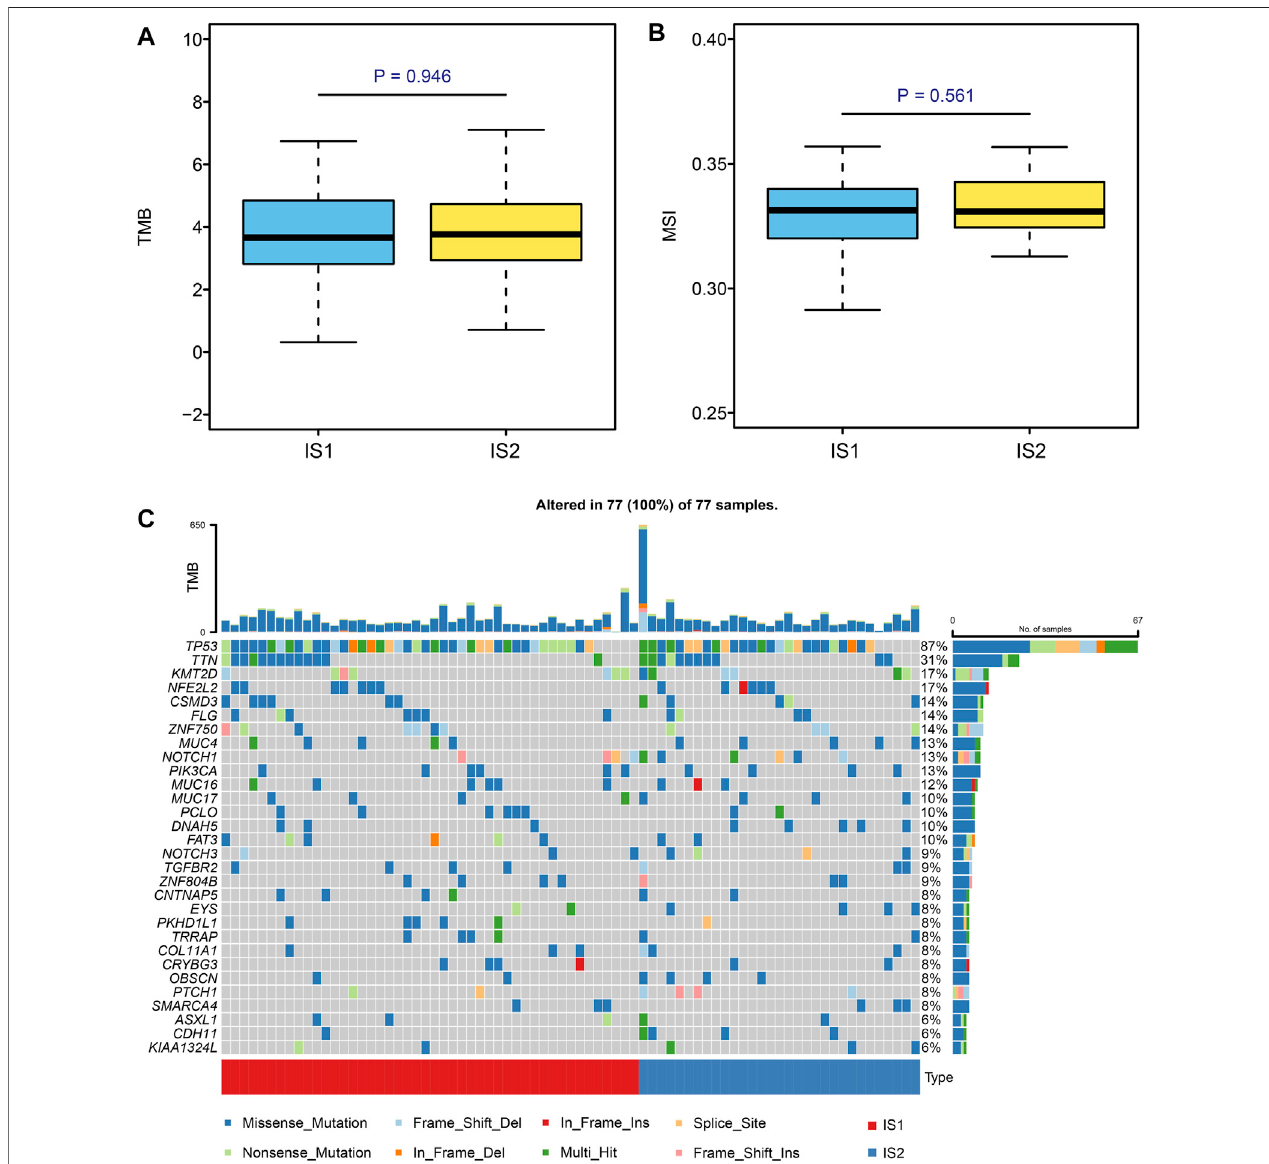
FIGURE6| Identi fi cation ofmutationsignatureindifferentsubtypes. (A,B) Comparison ofTMBandMSIinESCCpatientswithdifferentimmunesubtypes. (C) Top 30 mutated genes in the IS1 and IS2 subtypes.